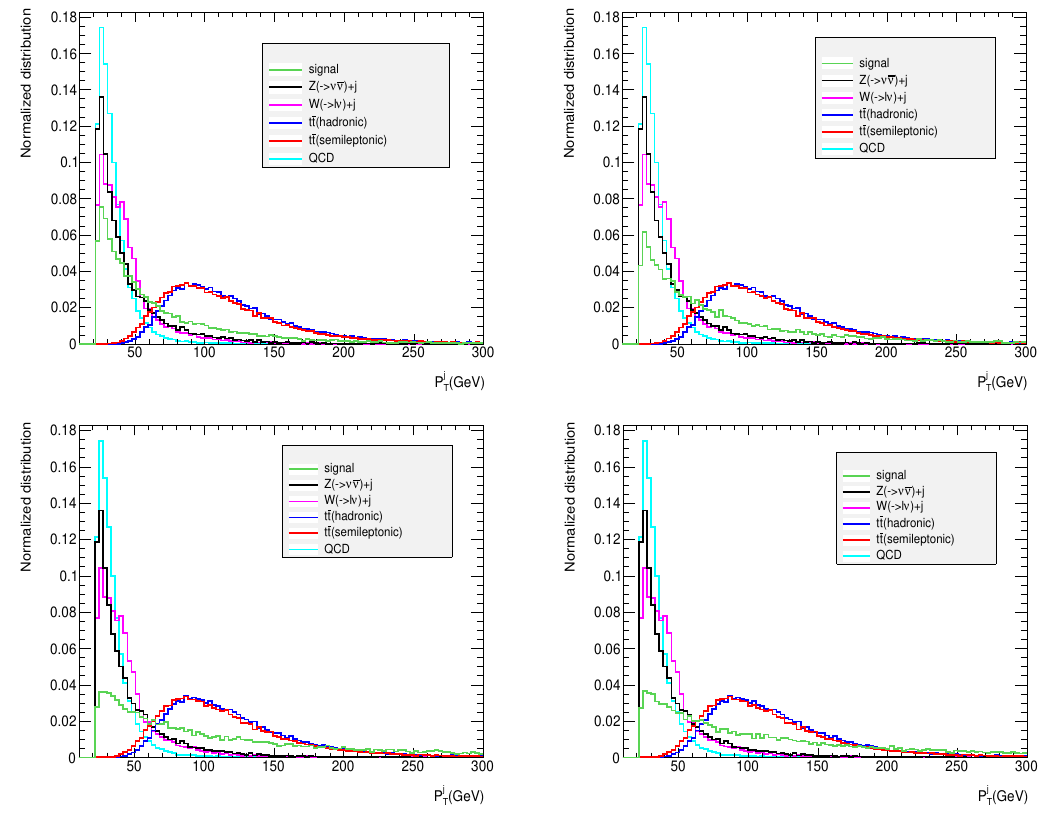
Figure 6 . P T distribution of the leading jet for gluon fusion signal and background processes, Type I BP I (top left), Type I BP II (top right), Type II BP I (bottom left) and Type II BP II (bottom